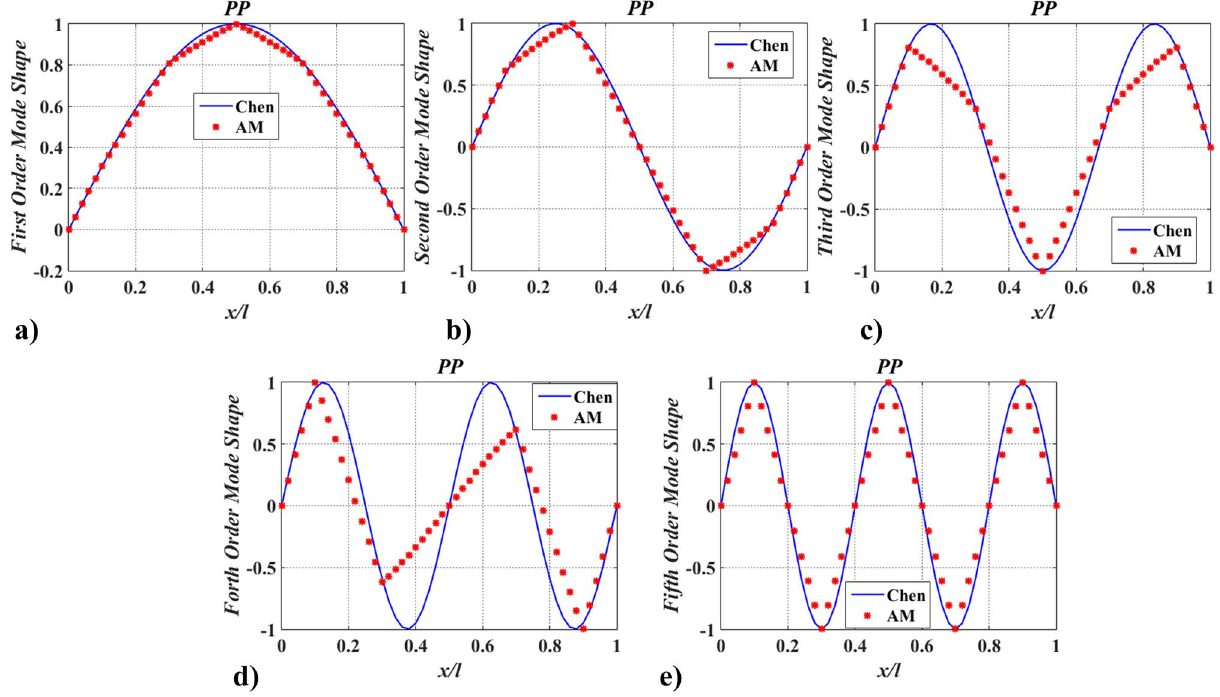
Figure 6. The lowest five mode shapes of twisting angles for the shaft carrying five concentrated elements in the PP support condition obtained from Chen 20 and AM (This figure was created via Matlab 2015, https:// ww2. mathw orks. cn/ produ cts. html?s_ tid= gn_ ps, sub-images in Figs. 6, 7, 13, 14, 16, 17, 18, 19, 20 were also created by Matlab 2015).